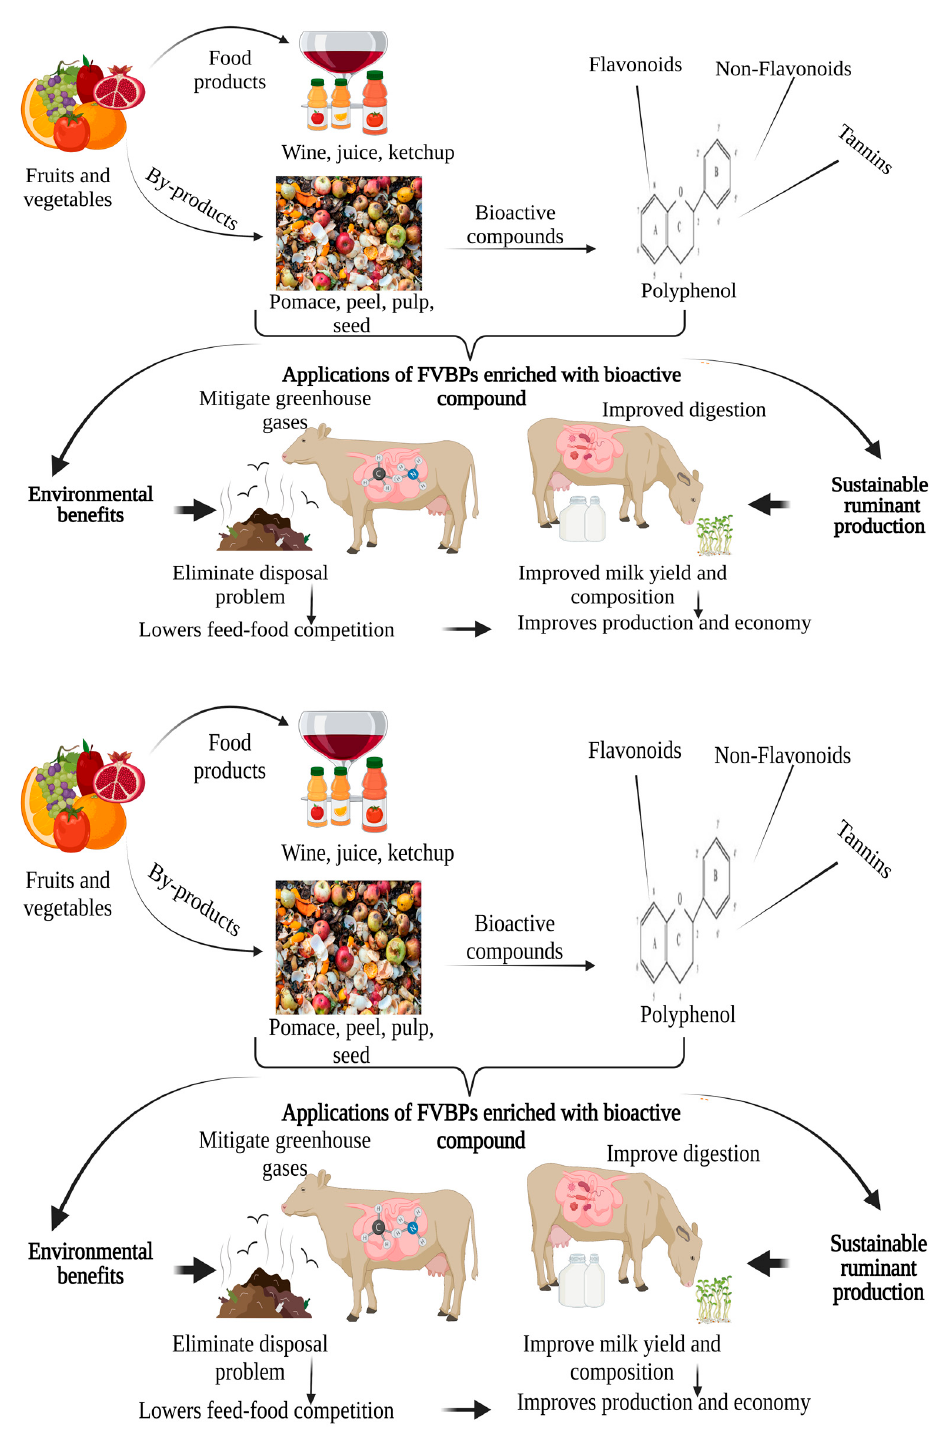
Figure 1. A summary of merits of using FVBPs in ruminant’s diets.